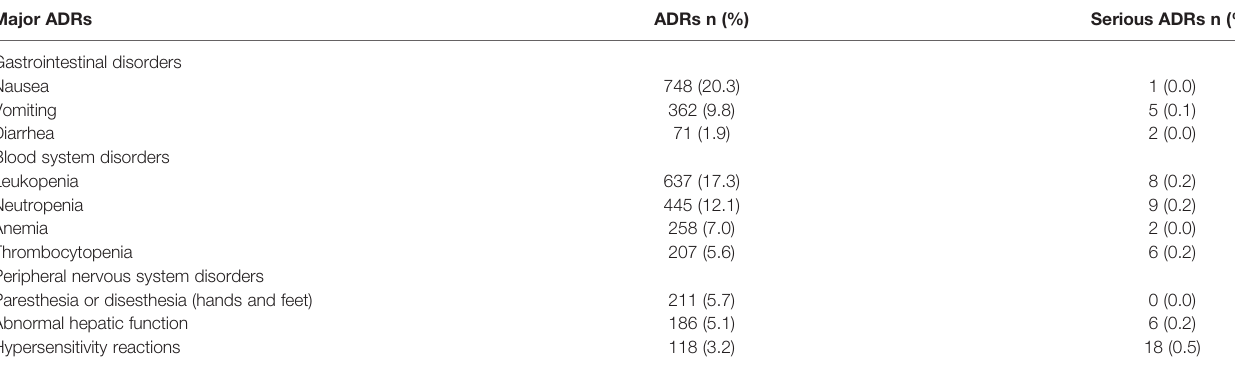
TABLE 3 | Incidence and severity of most frequently-occurring ADRs.